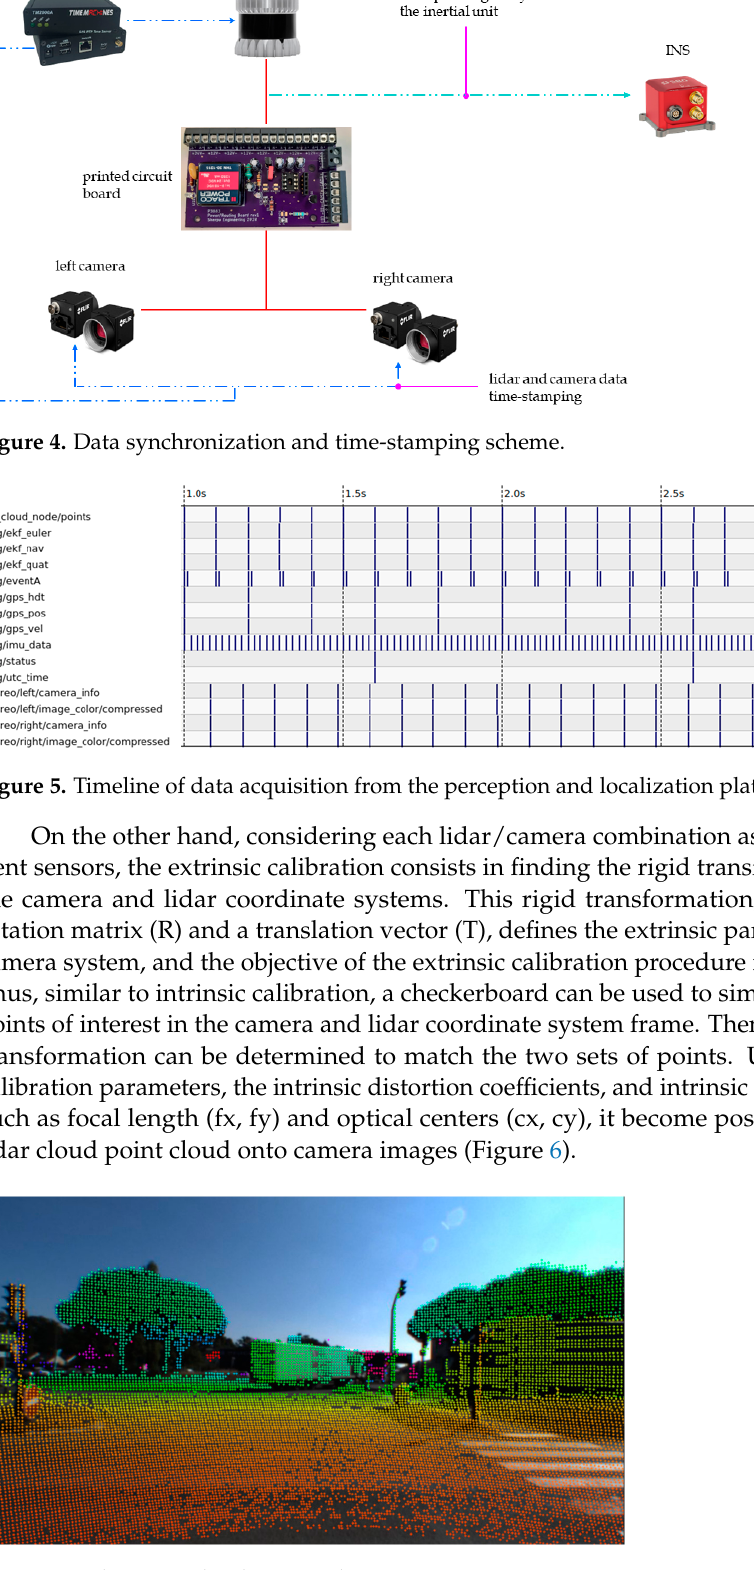
Figure 6. Lidar point cloud projected onto camera images.